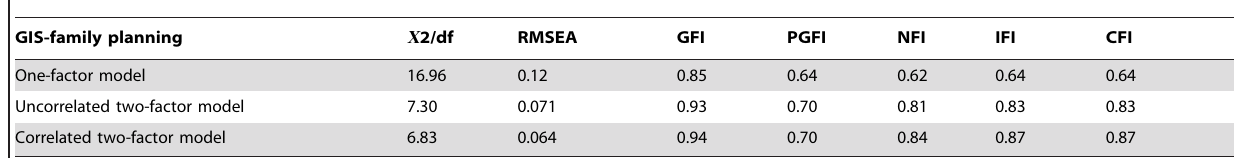
Table 5. Fit of Indices of CFA for 15-item GIS-family planning.